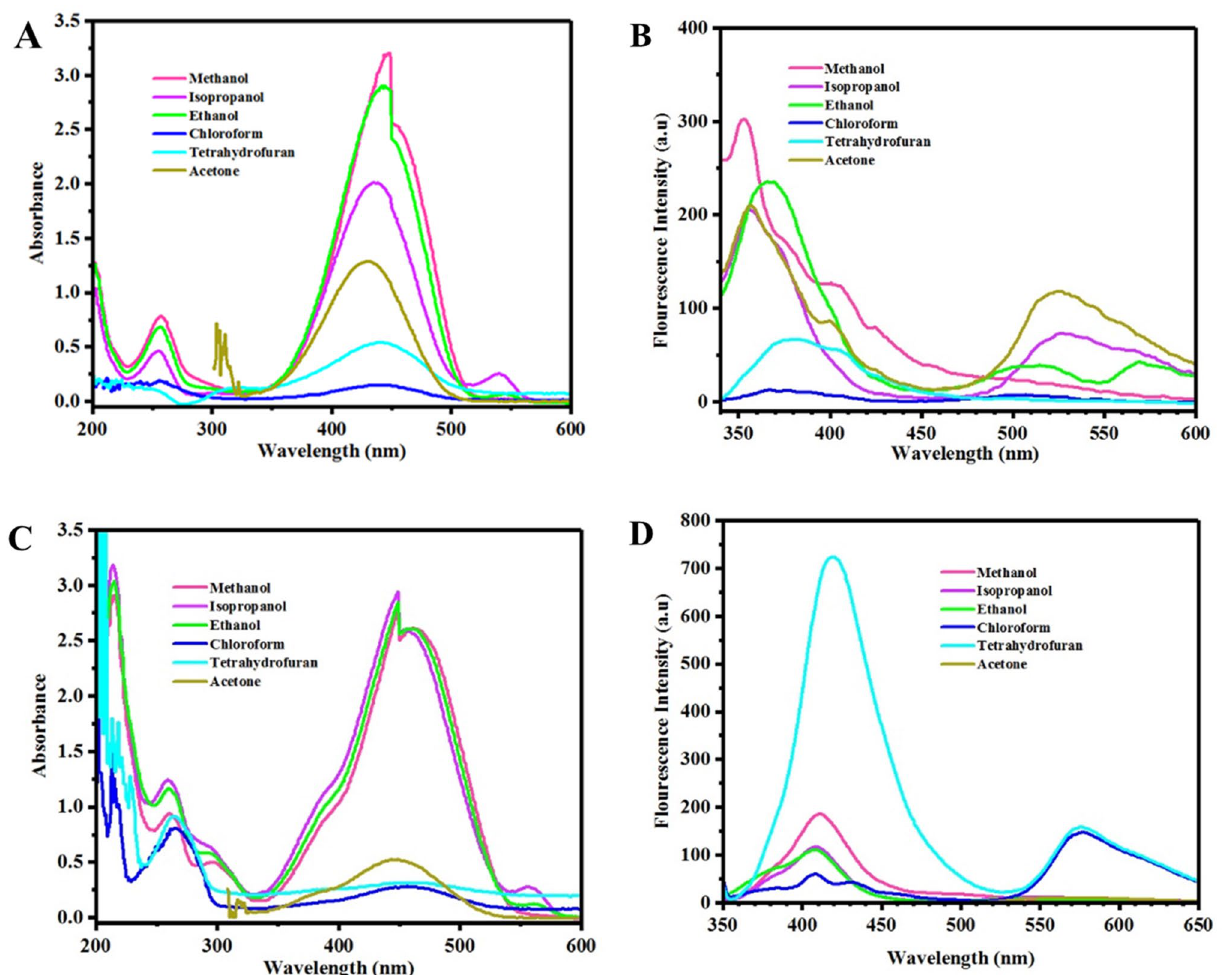
Figure 4. Investigation of solvatochromism behavior in different solvents using UV–Vis and fluorescence spectroscopis for ( A ) and ( B ) OX 1 -OH and ( C ) and ( D ) OX 2 -OH